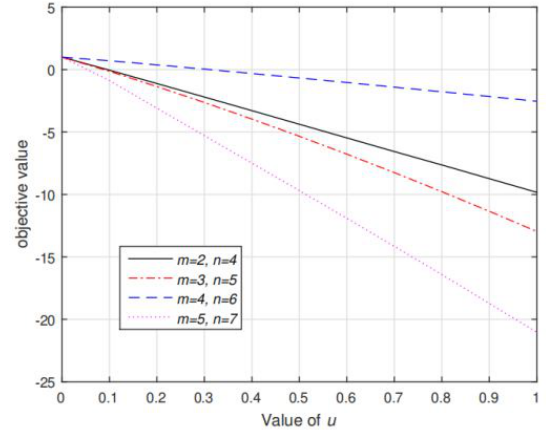
Figure 7. Value of the objective function f ( s / u ) as function of u under different settings of m , n . Given each fixed value of u , s / u is computed via Algorithm 2. Note that f ( s / u ) is monotonically decreasing in u